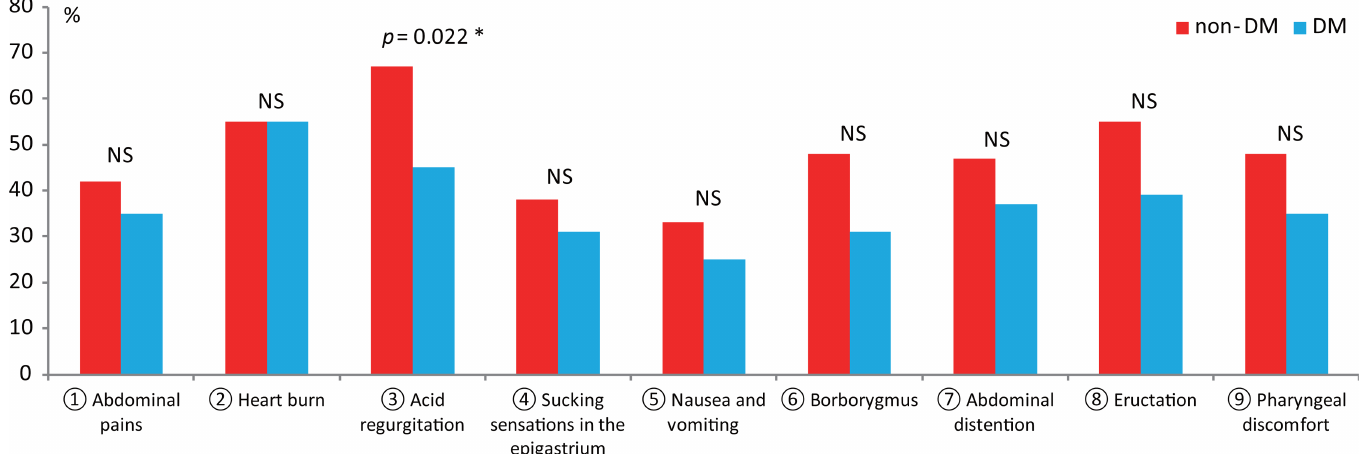
Fig 1. Percentage of positive GSRS scores ( (cid:21) 2) for items 1–9 in severe endoscopic GERD patients. The percentage of patients with GSRS scores (cid:21) 2 for items 1–9 in non-DM (n = 60) and DM (n = 51) patients with severe endoscopic GERD are shown.